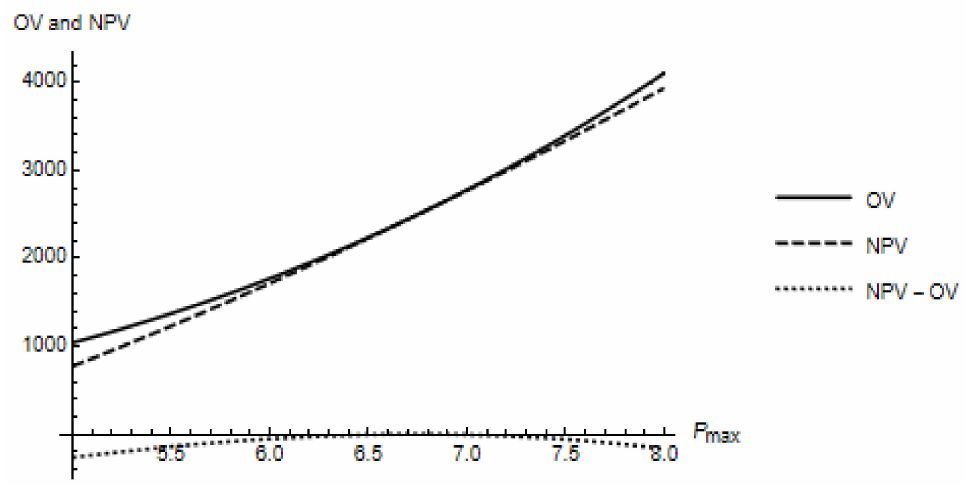
Figure 7. Real option, NPV, and opportunity cost of reinforcing the electrical